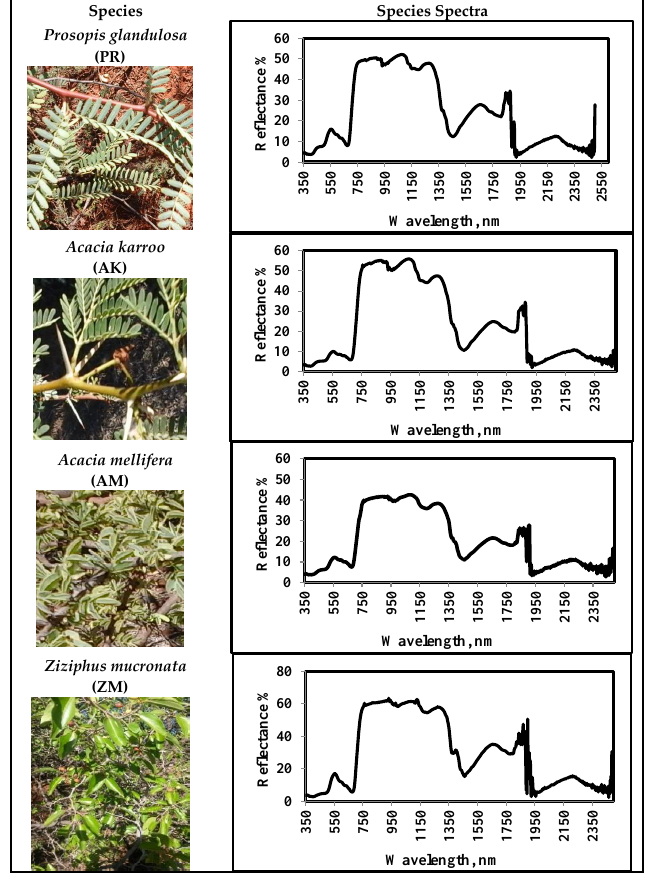
Figure 2. Images and spectra of Prosopis glandulosa and its co-existent